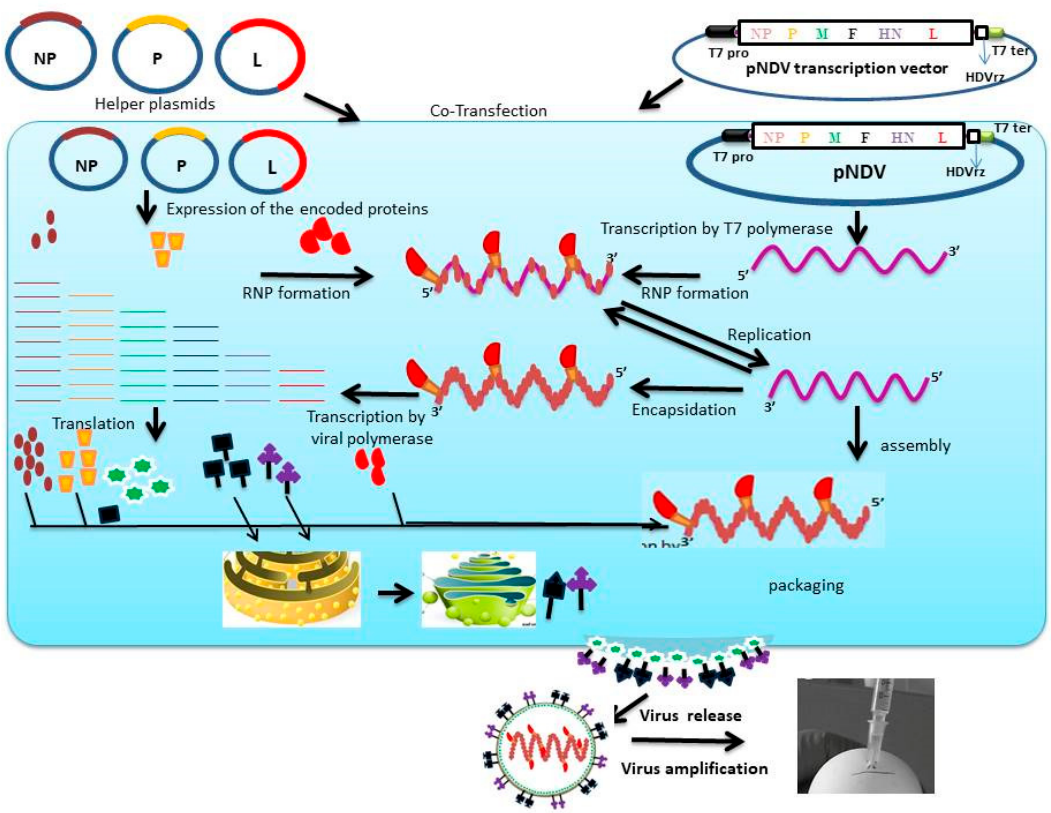
Figure 1. Reverse genetics approach for the generation of engineered Newcastle disease virus in BSR-T7 cells. Full length NDV antigenome flanked by T7 promoter (T7 pro), and autocatalytic hepatitis delta virus ribozyme (HDVrz) is cloned into the transcription vector to form pNDV. Helper plasmids (expression constructs for NP, P and L) are co-transfected with pNDV into BSR-T7 cells, which constitutively express T7 RNA polymerase. Within the cytoplasm, the T7 polymerase transcribes the viral RNA using the pNDV as a template. The helper plasmids express the encoded proteins for association with the transcribed RNA to form the ribonucleoprotein (RNP) template for onward replication cycles. The viral polymerase gradiently transcribes the viral genome into respective mRNAs, which are subsequently translated into proteins. NP, P and L proteins assemble with the newly synthesized negative sense viral RNA while the F and HN proteins are post-translationally modified in the endoplasmic reticulum and Golgi apparatus before being transported to the cell surface. The final event is the release of the recombinant virus by budding, which is then amplified in specific pathogen-free chicken embryonated